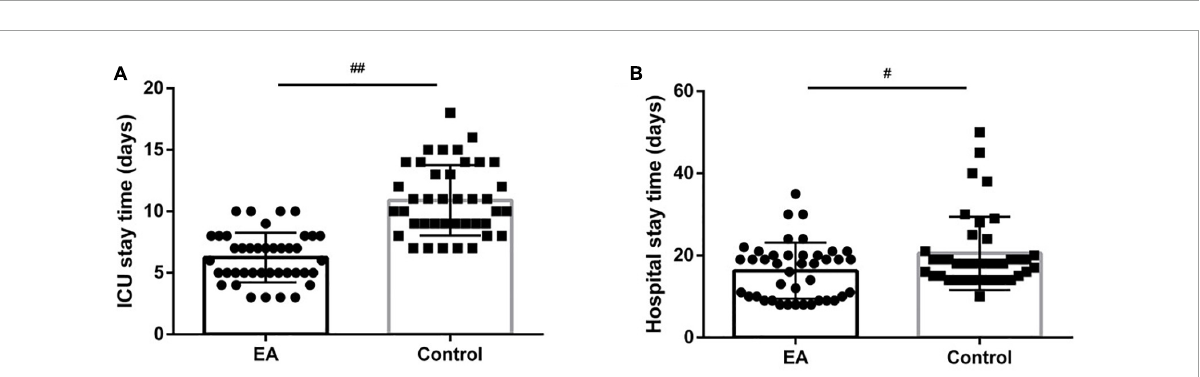
FIGURE4 Comparison of postoperative intensive care unit (ICU) stay and hospital stay between the two groups. (A) ICU stay; (B) hospital stay. # P < 0.05, ## P <